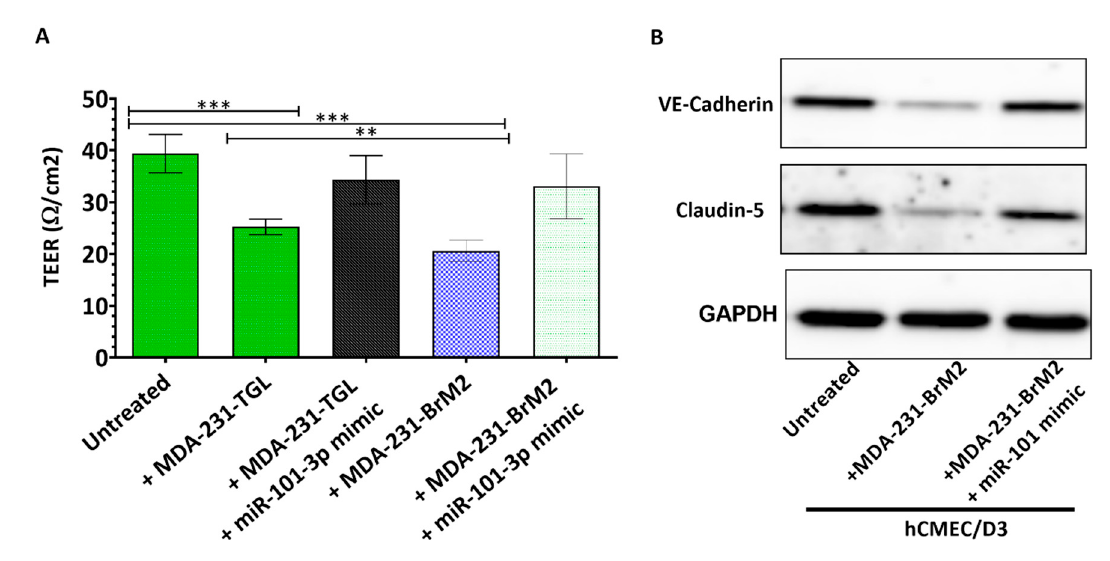
Figure 7. Ectopic upregulation of miR-101-3p in breast cancer cells preserves the brain endothelial inter-cellular junctions. ( A ) Transendothelial electrical resistance (TEER) was measured for brain endothelial cells co-cultured with MDA-MB-231-TGL and MDA-MB-BrM2 cells treated with miR-101-3p mimic or controls. ( B ) Western Blot analysis of VE-cadherin and claudin-5 protein expression was measured by Western blot in hCMEC / D3 co-cultured with MDA-MB-231-TGL and MDA-MB-BrM2 cells treated with miR-101-3p mimic or controls. Data are mean ± SD from three to six independent experiments. ** p < 0.01, *** p < 0.001.